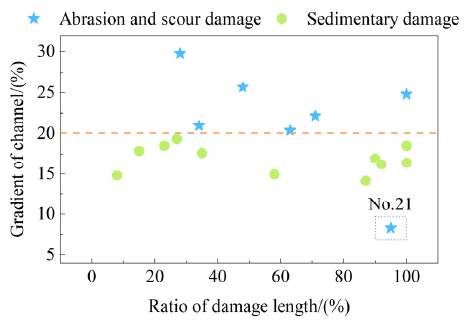
Figure 9. The relationship between the gradient of the drainage channel and damage type.